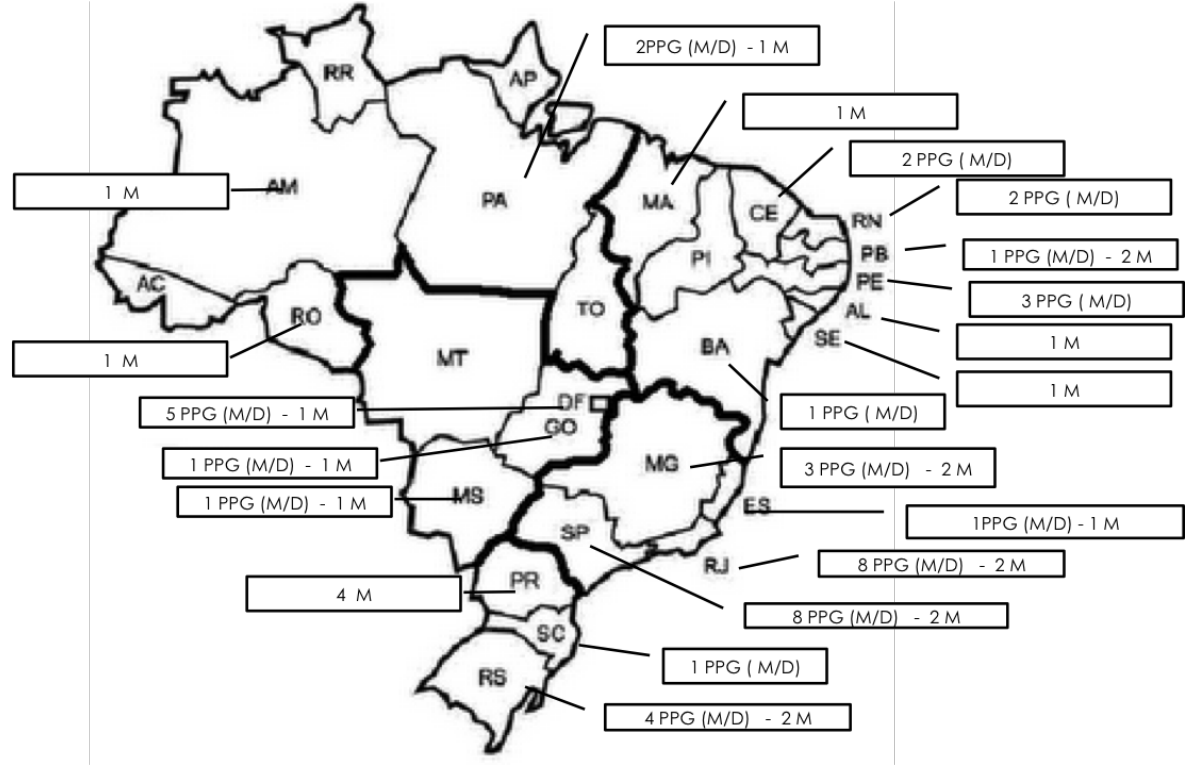
Figure 2. Distribution of Brazilian psychology postgraduate programs by states, in 2013. For each state, the number of Master’s and Doctorate (M/D), only Academic Master’s (M), and only Professional Master’s (P) programs